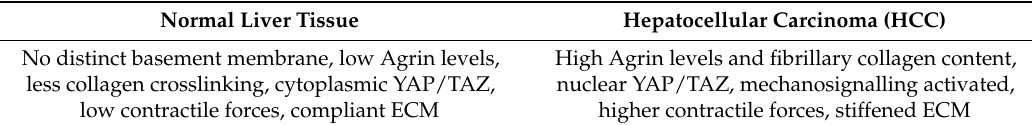
Table 1. Distinction between normal and HCC liver tissue matrices.